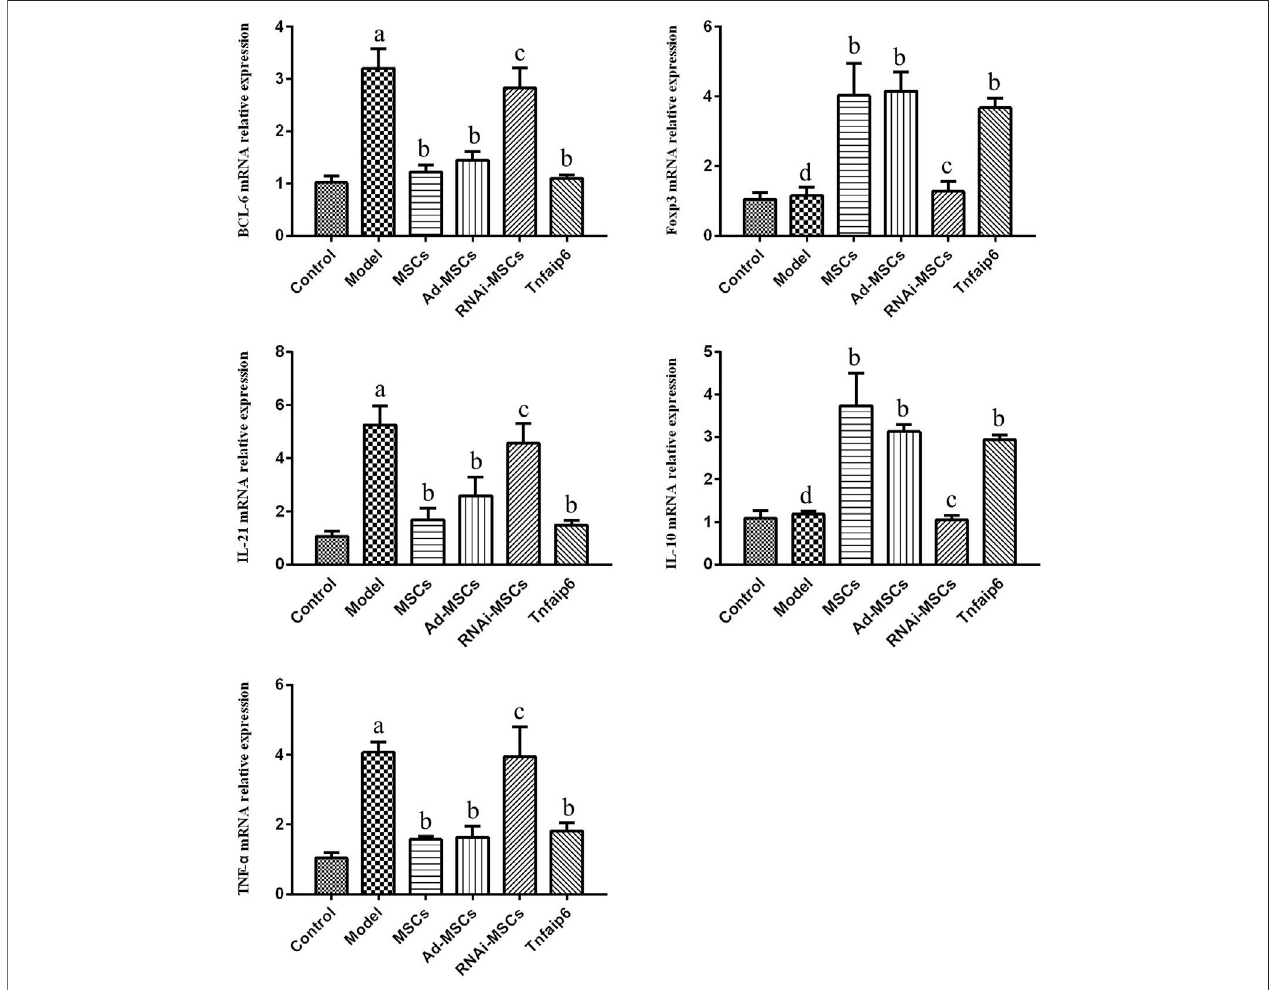
FIGURE 7 | Relative mRNA expression levels of BCL-6 , Foxp3 , IL-21 , IL-10 , and TNF - α determined by RT-qPCR in the colon. a p < 0.05 compared to the control group. b p > 0.05 compared to the model group. c p > 0.05 compared to the model group. d p > 0.05 compared to the control group. n ≥ 9 per group.